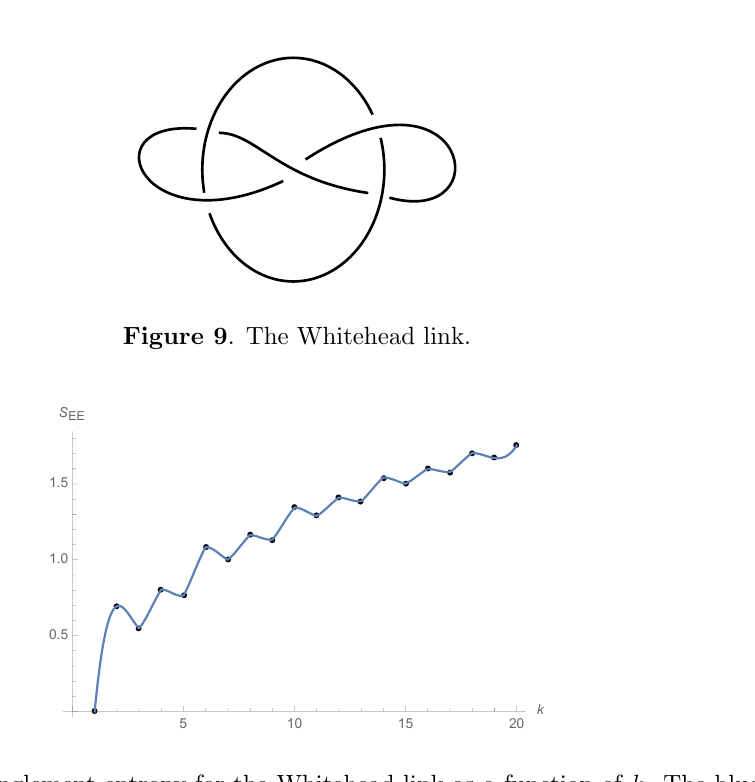
Figure 10 . The entanglement entropy for the Whitehead link as a function of k . The blue line is an interpolating